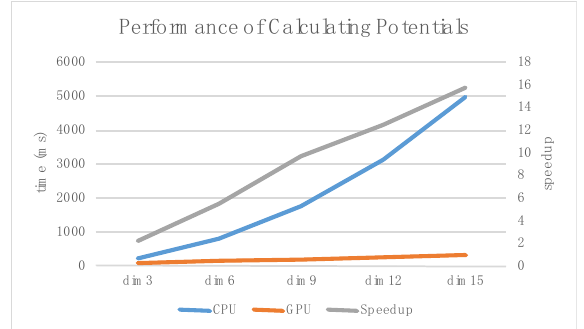
Fig. 6. Performance of calculating the